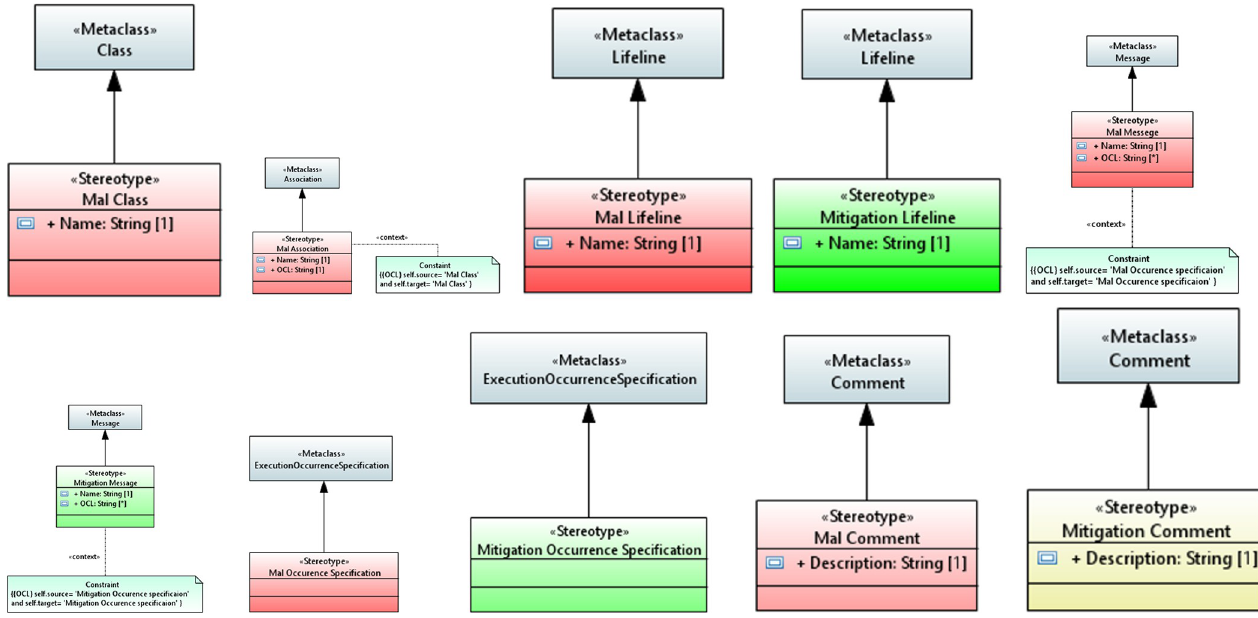
Fig 3. a. Mal class. b. Mal association. c. Mal lifeline. d. Mitigation lifeline. e. Mal message. f. Mitigation message. g. Mal occurrence specification. h. Mitigation occurrence specification. i. Mal comment. j. Mal comment.